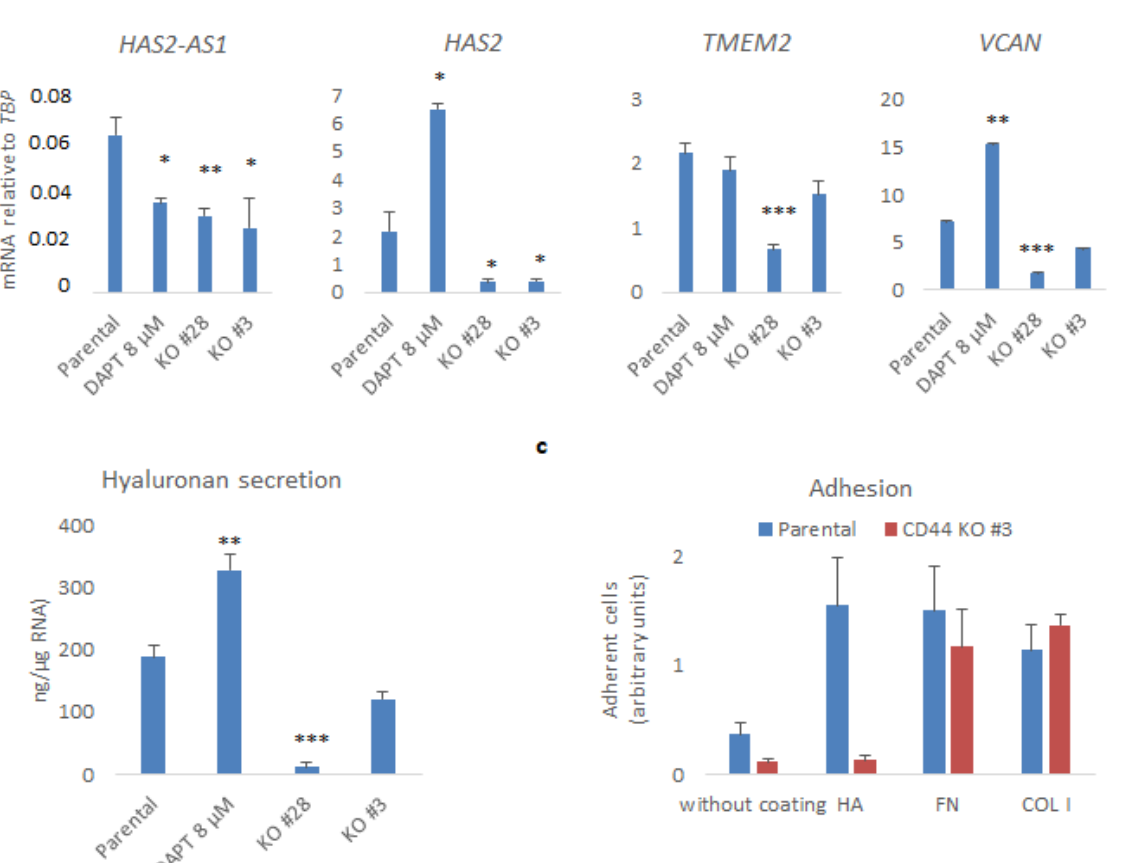
Figure 4. CD44 promotes hyaluronan production and adhesiveness of U251MG cells. ( a ) HAS2-AS1 , HAS2 , TMEM2 , and VCAN mRNAs were determined by real-time qPCR analysis after normalization to TBP . ( b ) The hyaluronan levels in conditioned medium were measured and normalized to total RNA extracted from cells cultured in the indicated conditions. ( c ) An equal number of suspended parental or CD44 KO U251MG cells (Clone #3) was subjected to adhesion assay to uncoated plates or plates coated with hyaluronan (HA), fibronectin (FN), or collagen type I (COL I); after 30 min, adherent cells were stained with crystal violet. Results are depicted as arbitrary absorbance units. All graphs show the average ± SEM values of at least three independent experiments. Asterisks show significant differences compared to the respective control condition: * p < 0.05, ** p < 0.01, *** p <